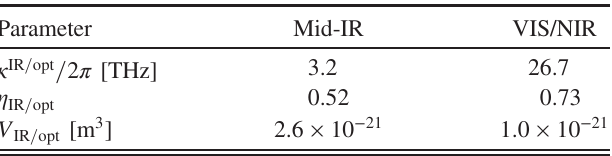
TABLE III. Antenna parameters as obtained from our FEM simulations. κ IR = opt are the total decay rates of IR (respectively, optical) energy stored in the antenna, η radiative efficiencies defined as κ IR = opt ex = κ IR = opt , and V mode